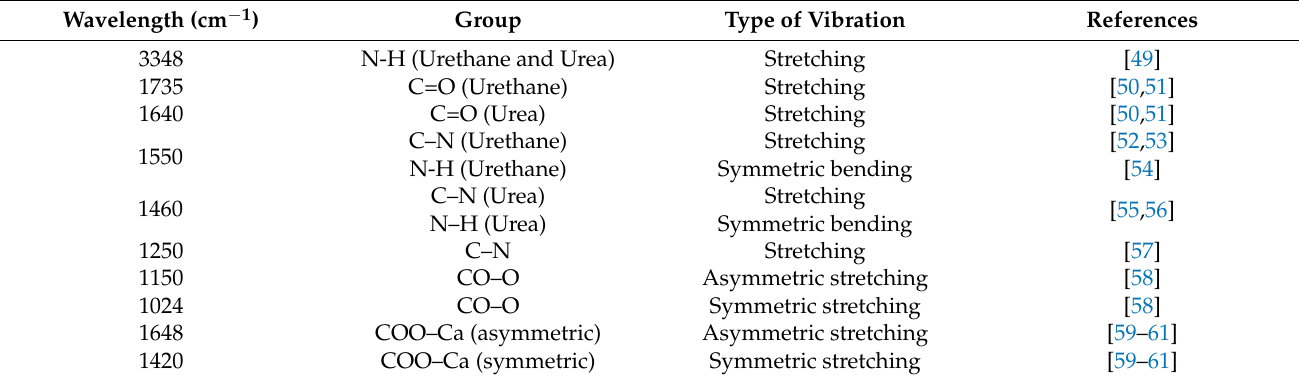
Table 3. Assignments of FTIR bands for WBPUU and WBPUU crosslinked with Ca 2+